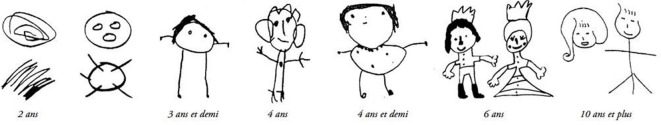
Drawings corresponding to each developmental stage.